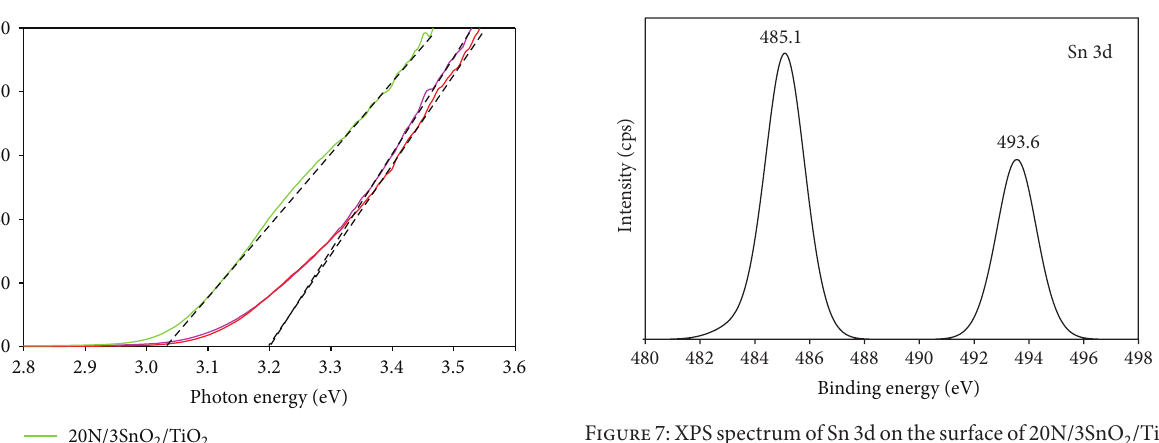
Figure 7: XPS spectrum of Sn 3d on the surface of 20N/3SnO 2 /TiO 2 thin film, calcined at 600 ∘ C.